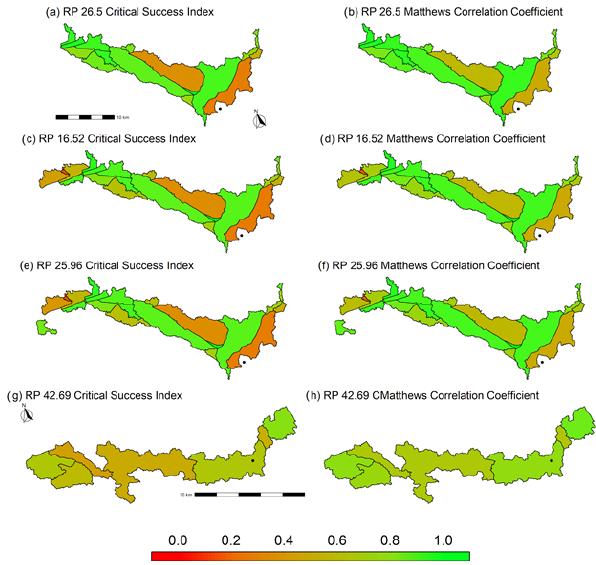
Figure 7. Binary classification results – Ottawa River watershed.